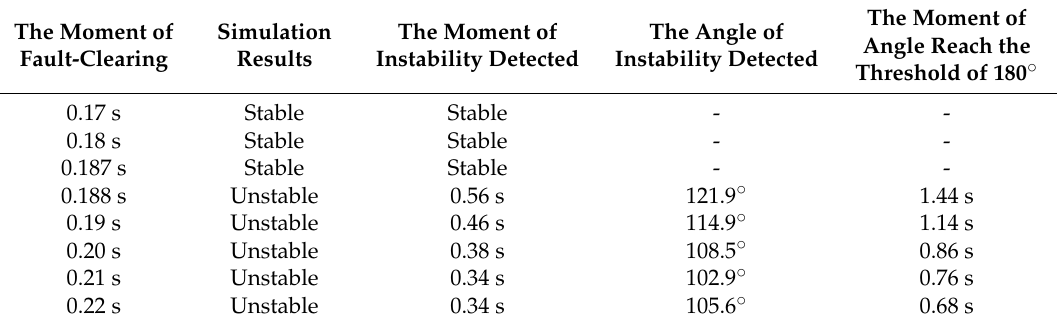
Table 3. The transient stability detection results by 50 Hz sample frequency.